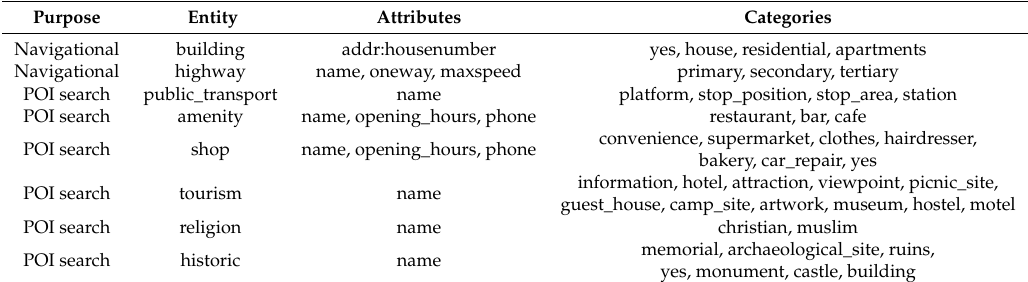
Table 1. Selected entities, attributes and categories of the completeness study.